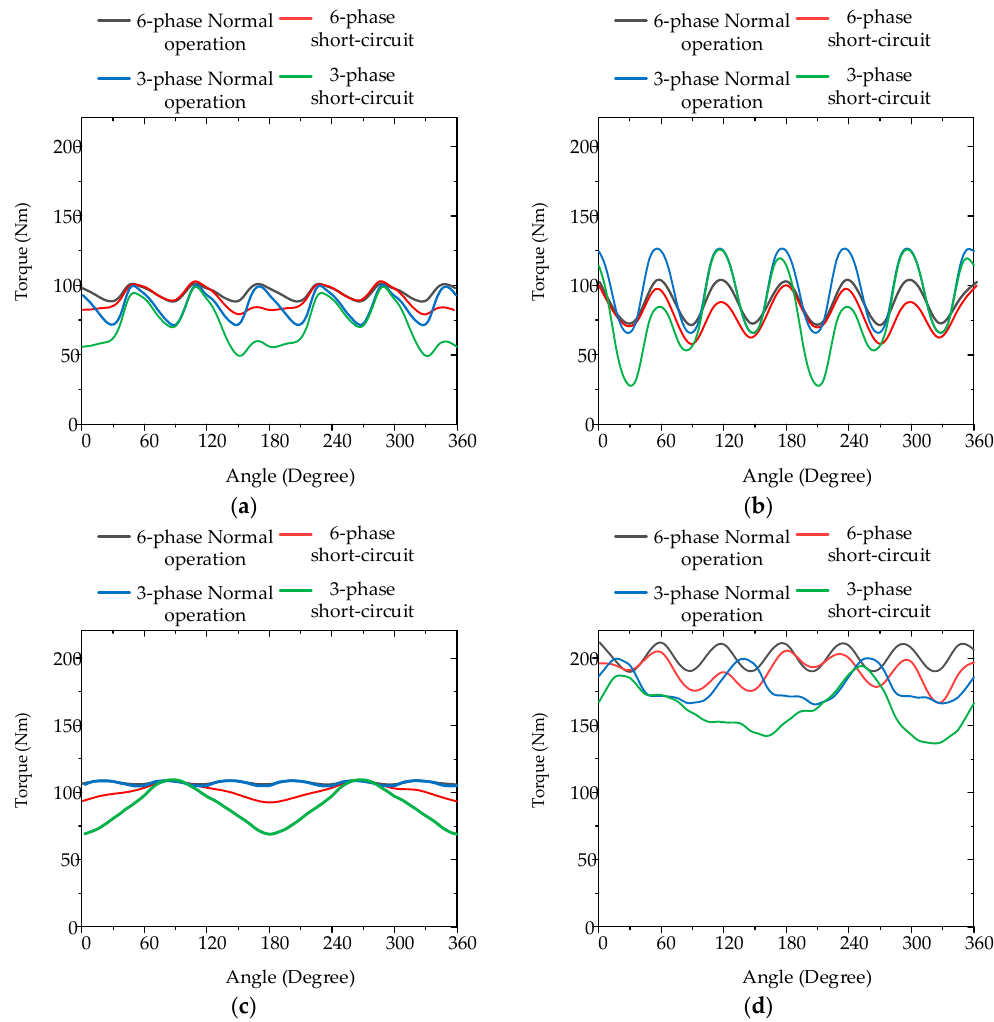
Figure 13. Steady torque of proposed outer-rotor PM machines of both six-phase and three-phase occur to short-circuit condition: ( a ) IPM type; ( b ) SPM type; ( c ) PMFS type; ( d ) PMV type.